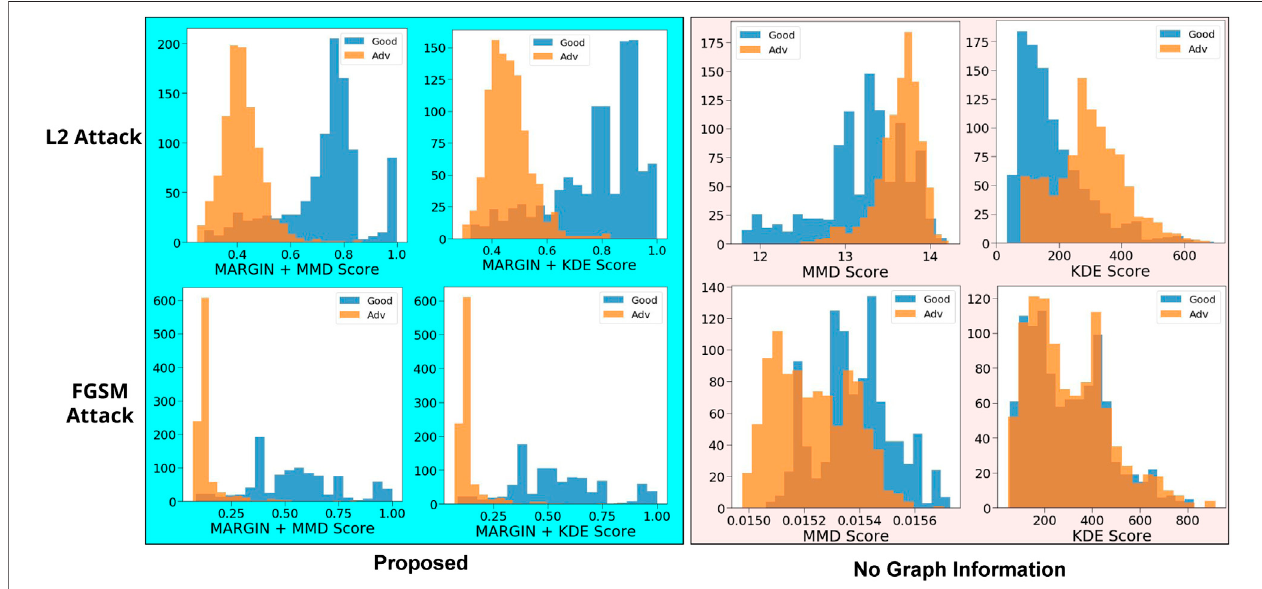
FIGURE 7 | We compare histograms of scores obtained from adversarial samples with and without incorporating graph structure. We see that including the structure results in a much better separation between adversarial and harmless examples. In addition, regions of overlap can easily be